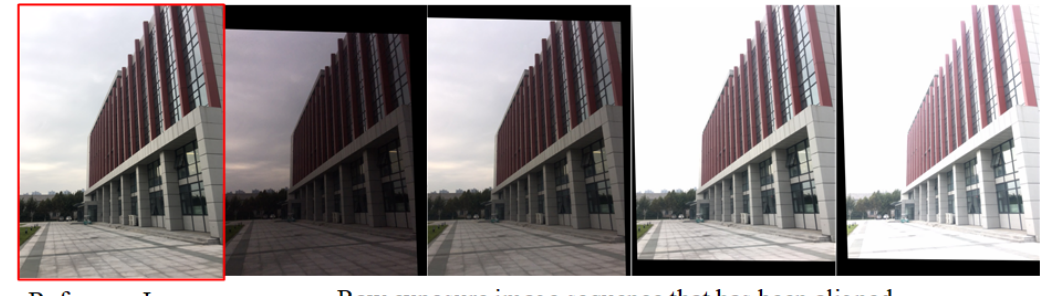
Figure 5. The results of image registration.